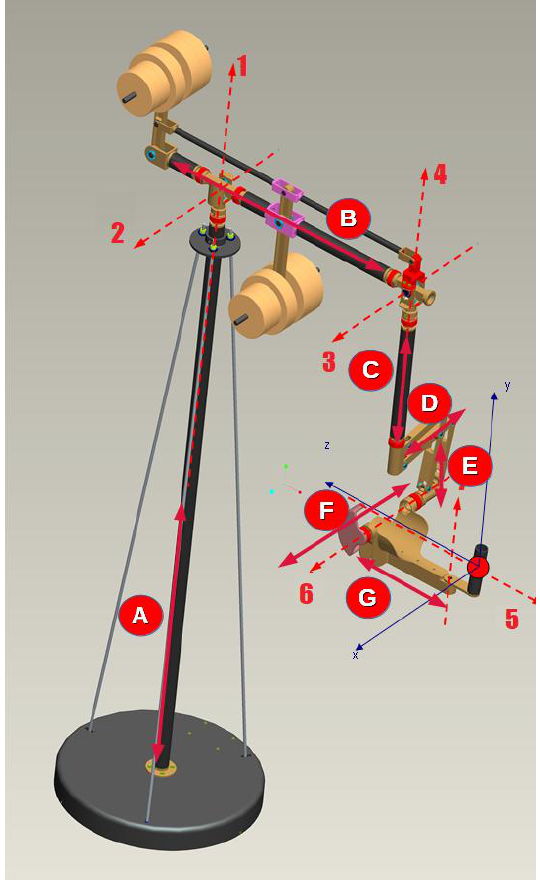
Figure 2. Track-Hold axes. The length of arm A (identified by a number inside a red circle) is about 2200 mm, arm B is about 1200 mm, arm C is about 1000 mm, arm D is about 250 mm, arm E is about 250 mm, arm F is about 250 mm, and G is about 250